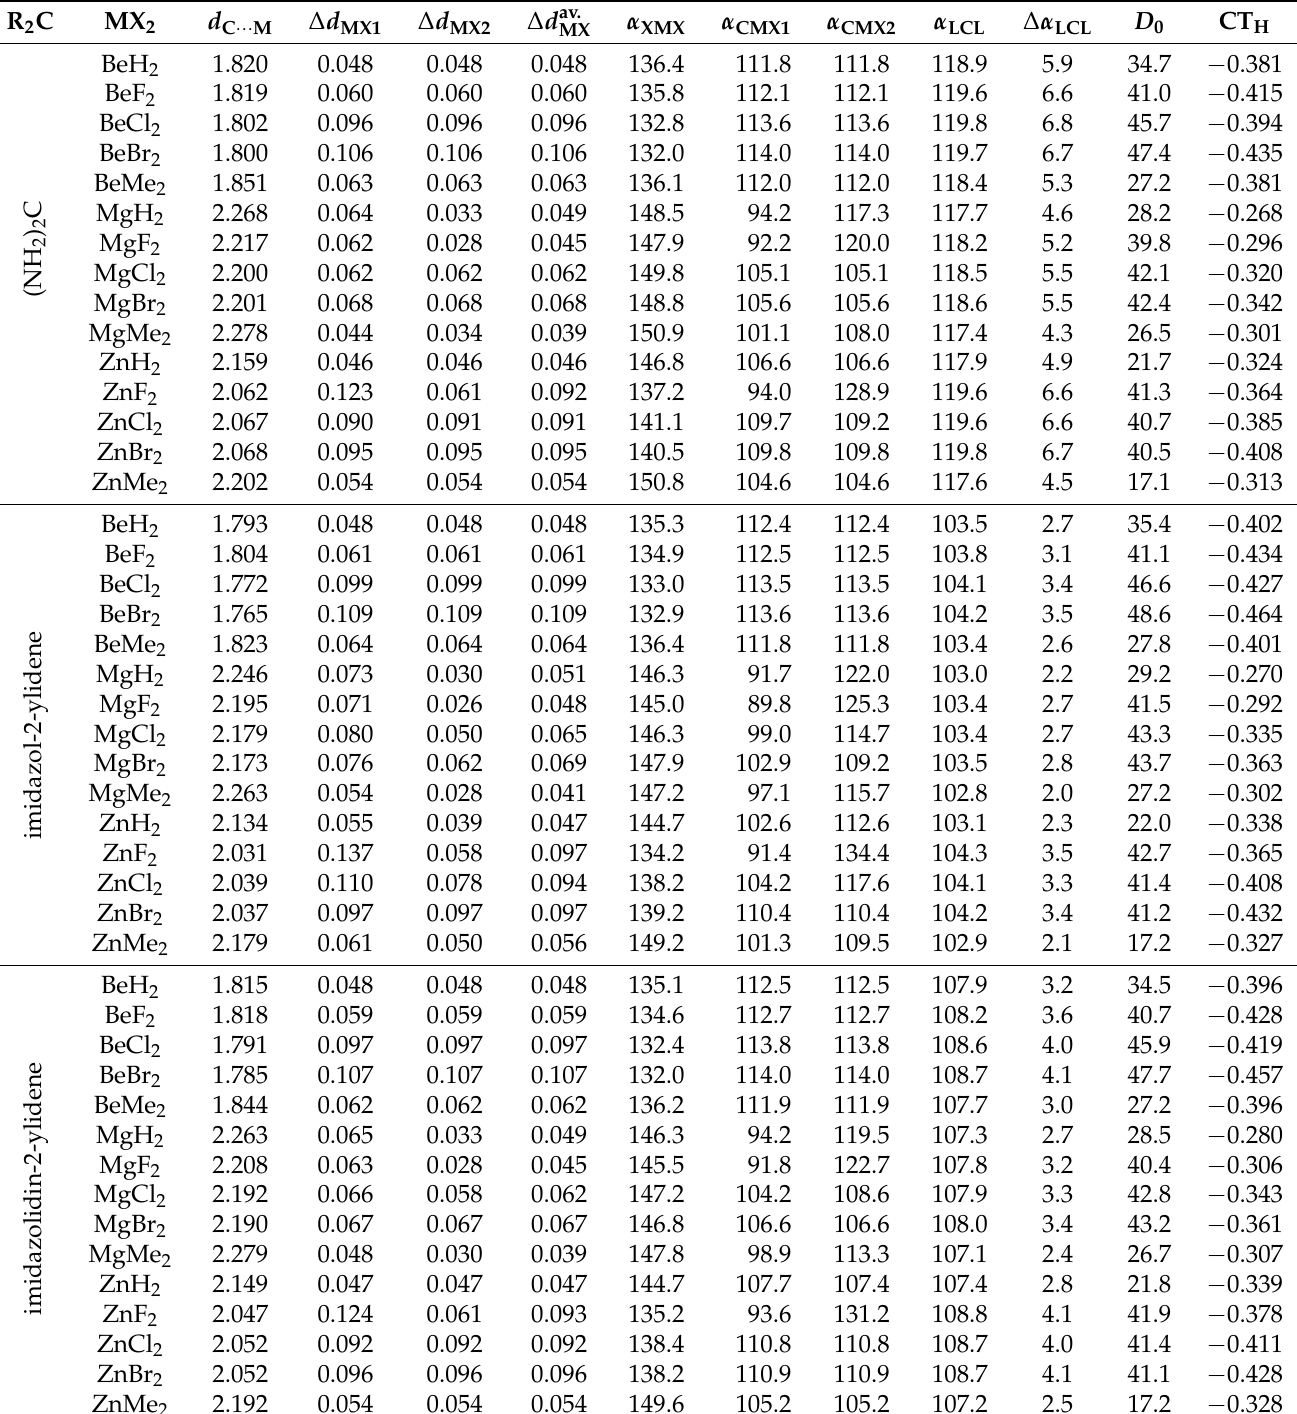
Table 3. Some fundamental data characterizing carbene · · · MX 2 dimers: C · · · M distance (in Å), changes of MX1 and MX2 bond lengths (in Å), XMX, CMX1, CMX2, LCL angles (in degrees), dissociation energy (in kcal/mol), charge transfer (in